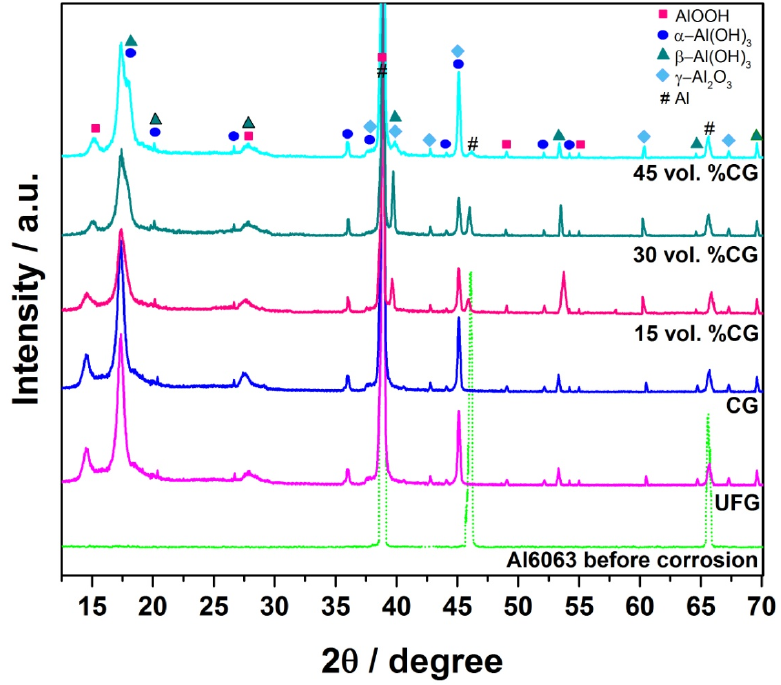
Figure 9. X ‐ ray diffraction (XRD) patterns of Al6063 samples after corrosion tests. Figure 9. X-ray diffraction (XRD) patterns of Al6063 samples after corrosion